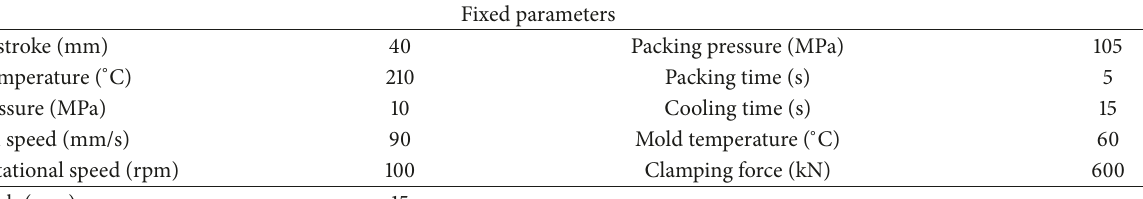
Table 10: Process parameter settings for shot-by-shot melt viscosity fluctuation experiments.